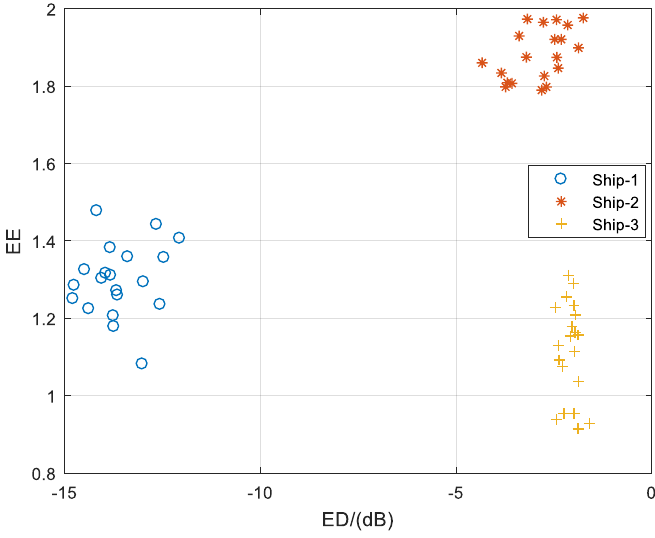
Figure 8. The hybrid feature distribution for S-RN signals.